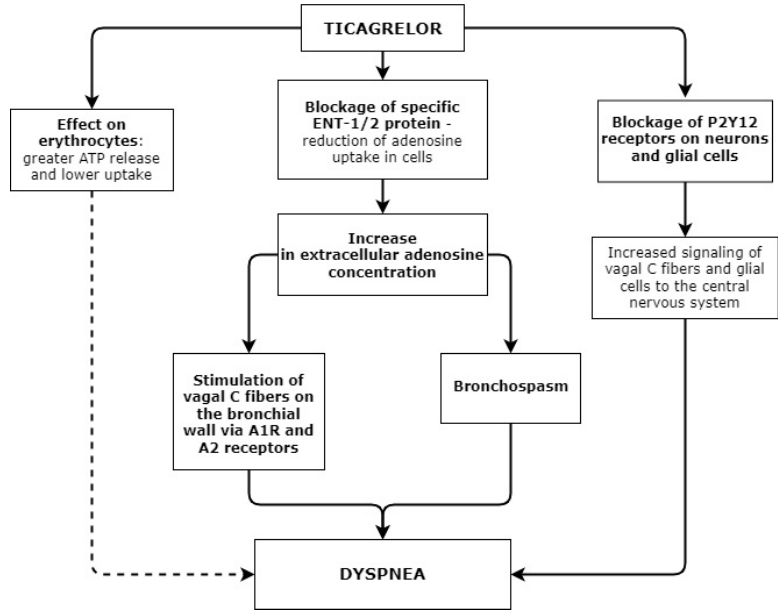
Figure 1. Possible mechanisms of ticagrelor-related dyspnea.